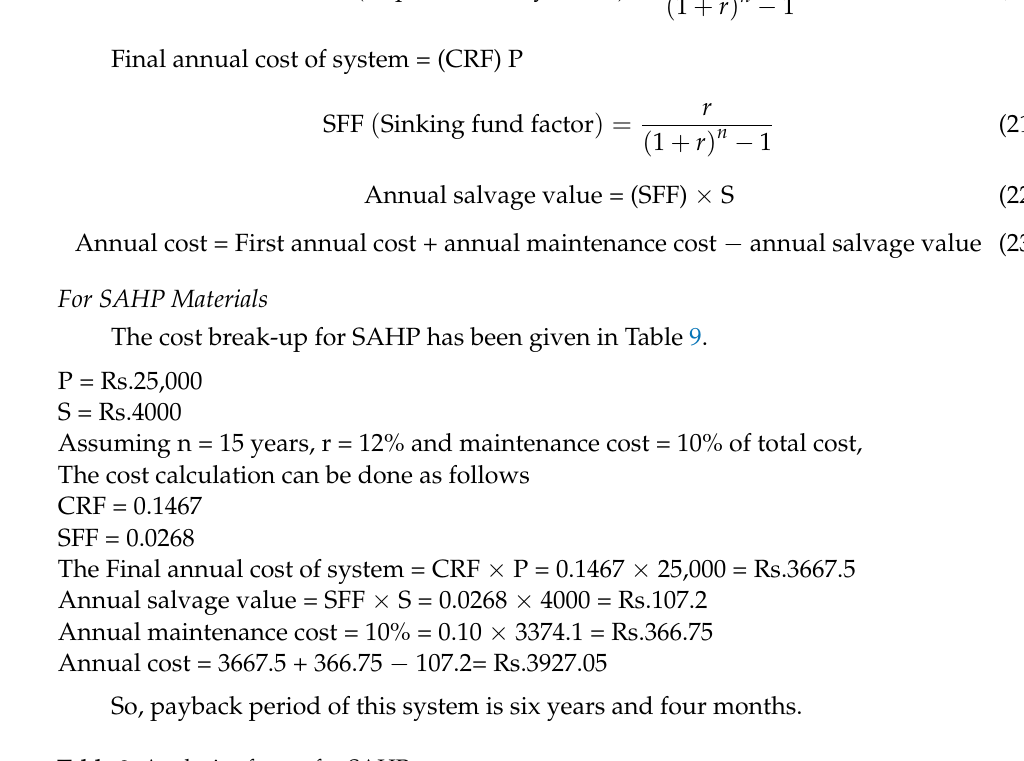
Table 9. Analysis of costs for